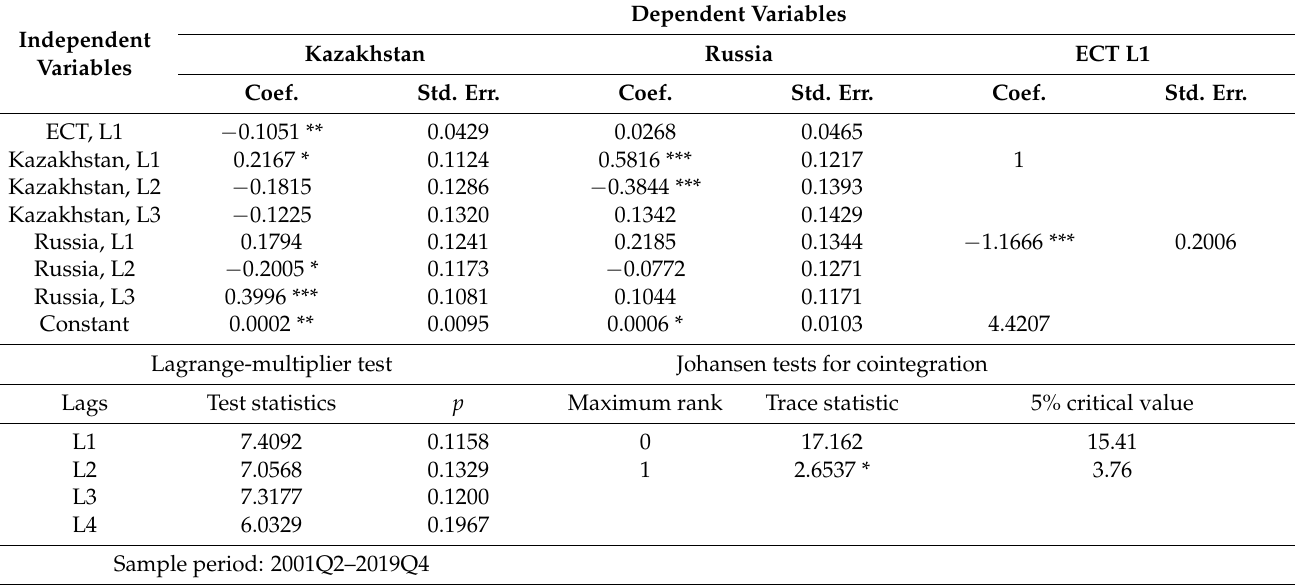
Table 11. VECM Estimation Results for Logarithmic Difference of GDP, Kazakhstan.